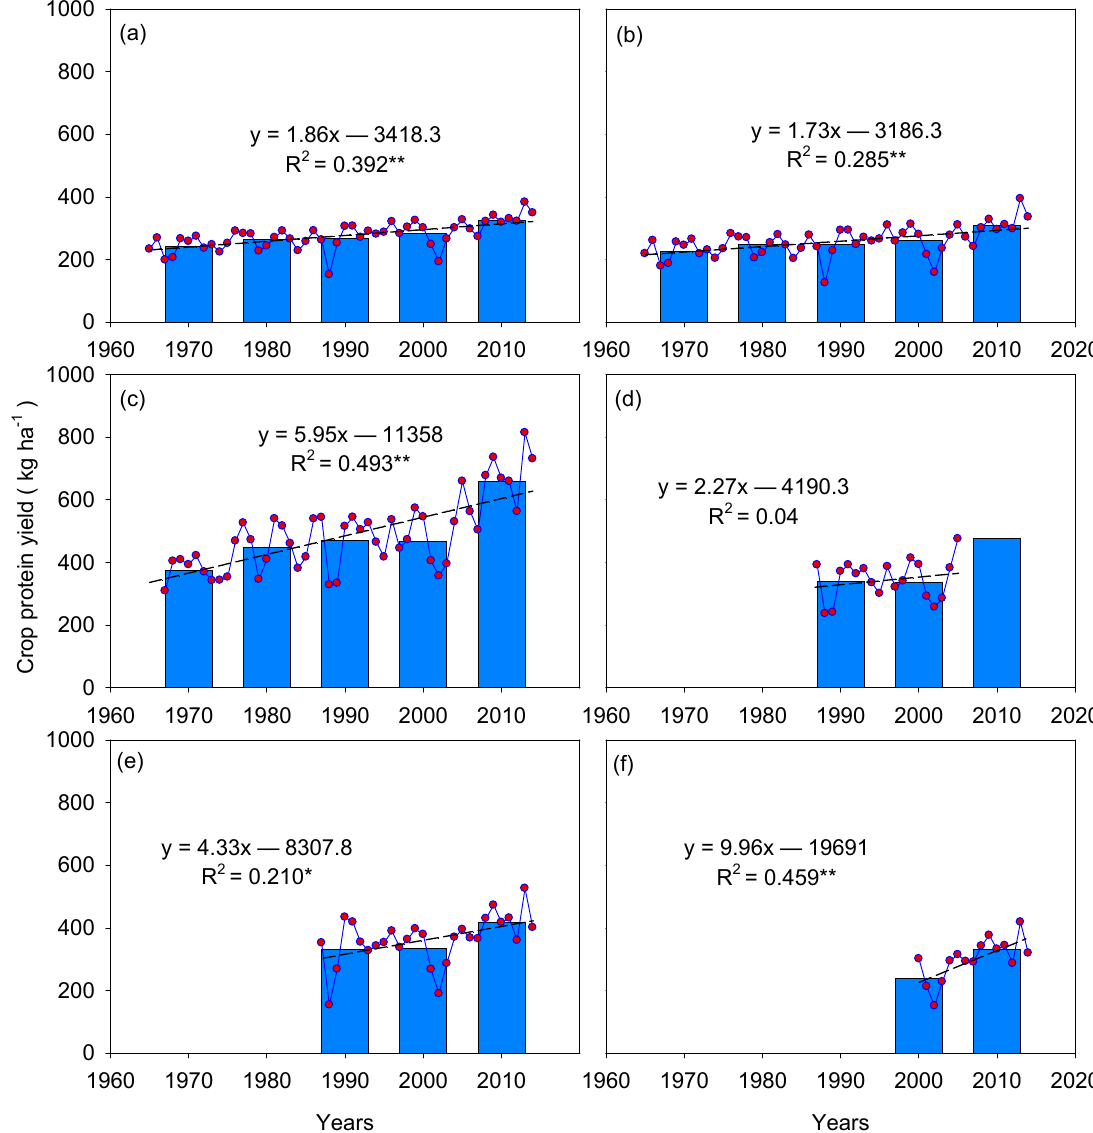
258 kg ha − 1 . The protein yield of canola ranged from 374 kg ha − 1 to 657 kg ha − 1 with an average of 488 kg ha − 1 . The protein yield of sunflower ranged from 339 kg h − 1 to 476 kg h − 1 with an average of 346 kg ha − 1 . The protein yield of lentil ranged from 331 kg ha − 1 to 417 kg ha − 1 with an average of 363 kg ha − 1 . The protein yield of chickpea ranged from 237 kg ha − 1 to 332 kg ha − 1 with an average of 301 kg ha − 1 . As a result of the different crop protein contents, oilseed crops had the largest protein yield among all crops, followed by pulse crops and cereal crops (Figure 5).